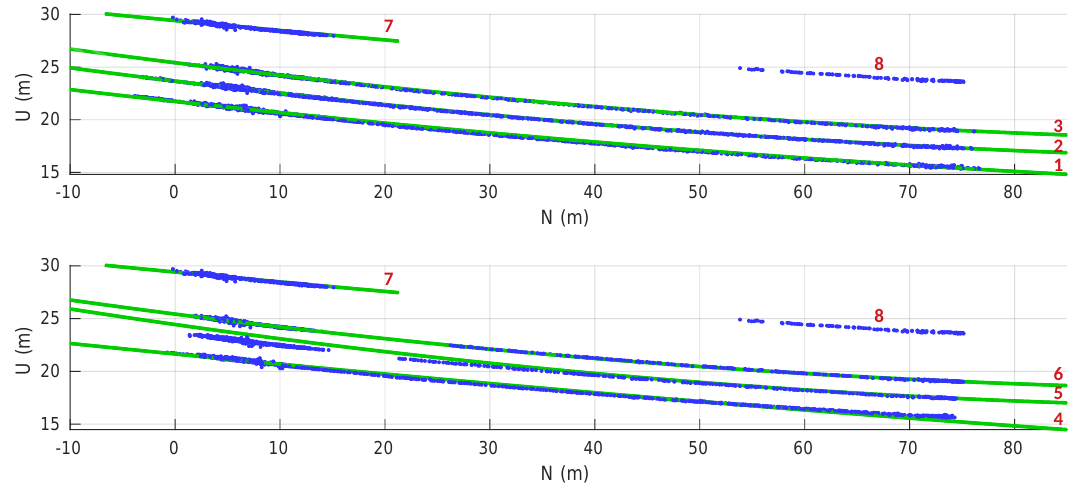
Figure 16. Horizontal analysis of estimated power line models (green) and line segments centers (blue).